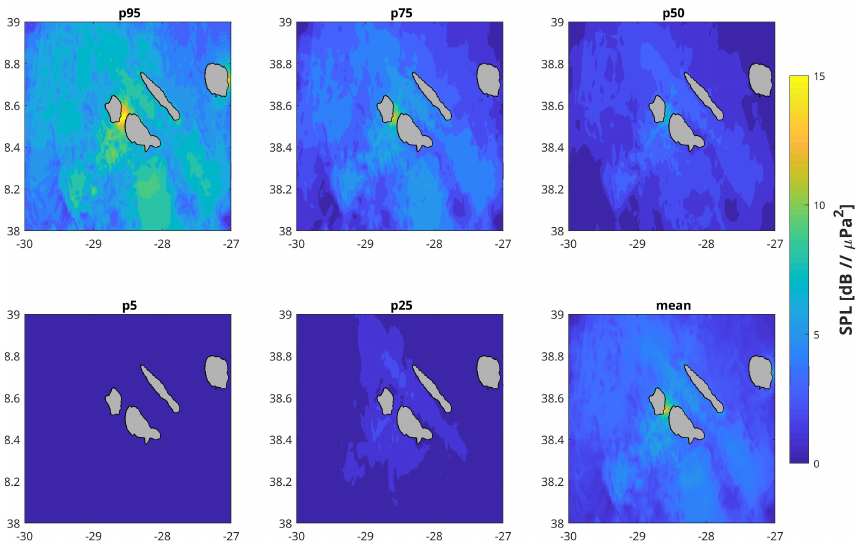
Figure 11. Data-calibrated instantaneous broadband excess noise level (ENL) predicted percentiles and time mean in [40–1000]Hz band at 10m depth for the wider group of islands, in June 2018 with a spatial and time resolution of 500m and 10 min, respectively (axes: Latitude (y), Longitude (x) both in decimal arc